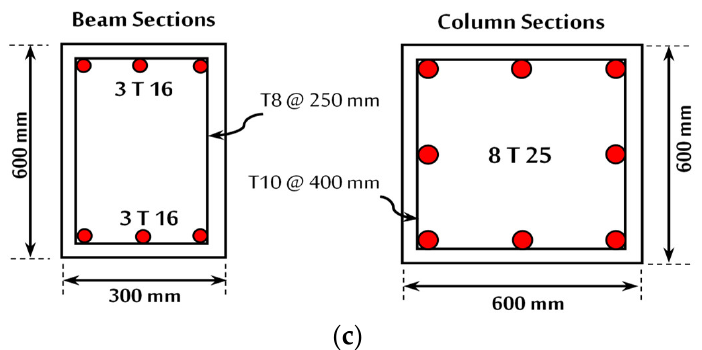
Figure 16. Reinforcement details of the specimens of the two frame scenarios of progressive collapse: